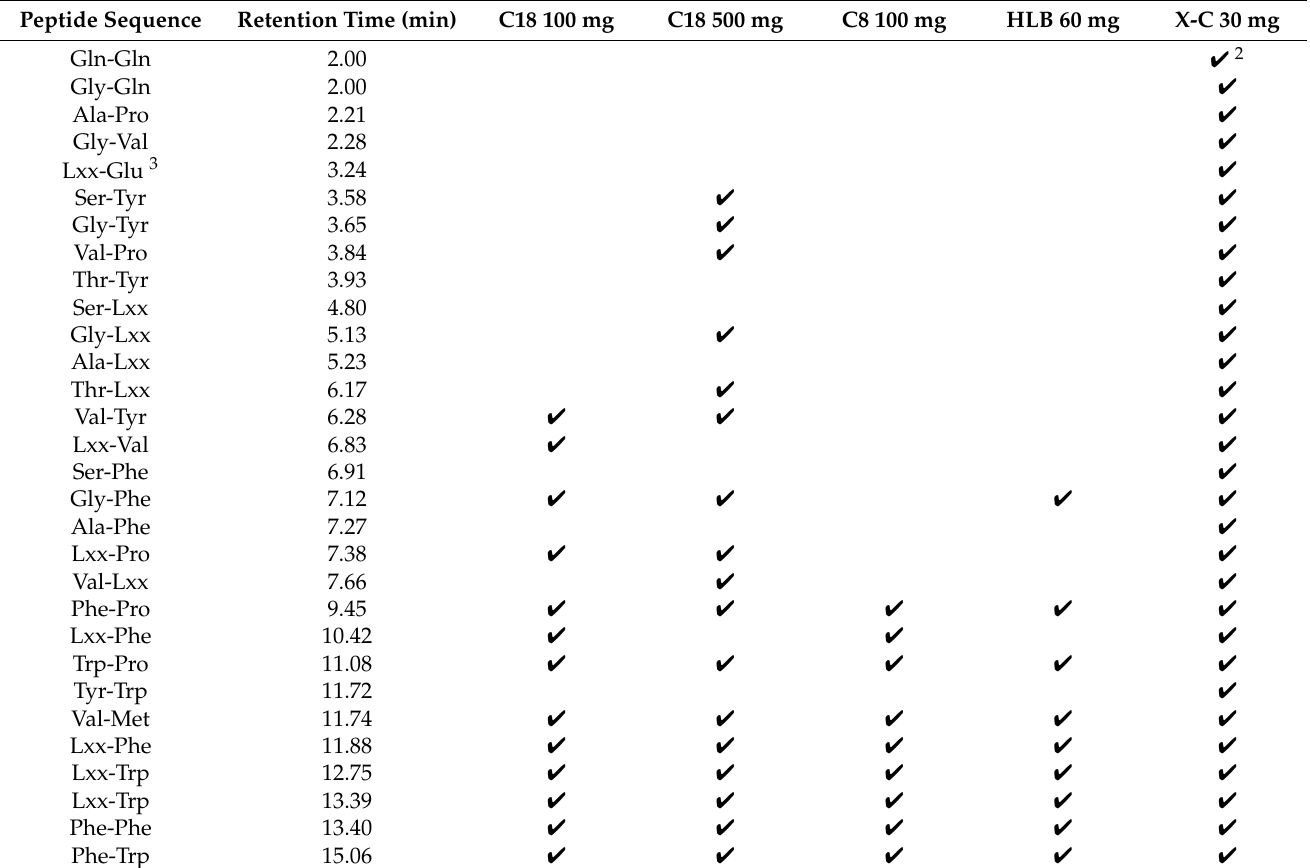
Table 3. Dipeptides identified with LC-MS/MS in the high-organic fractions, of the proteolyzed almond extract, prepared with each solid-phase extraction technique 1